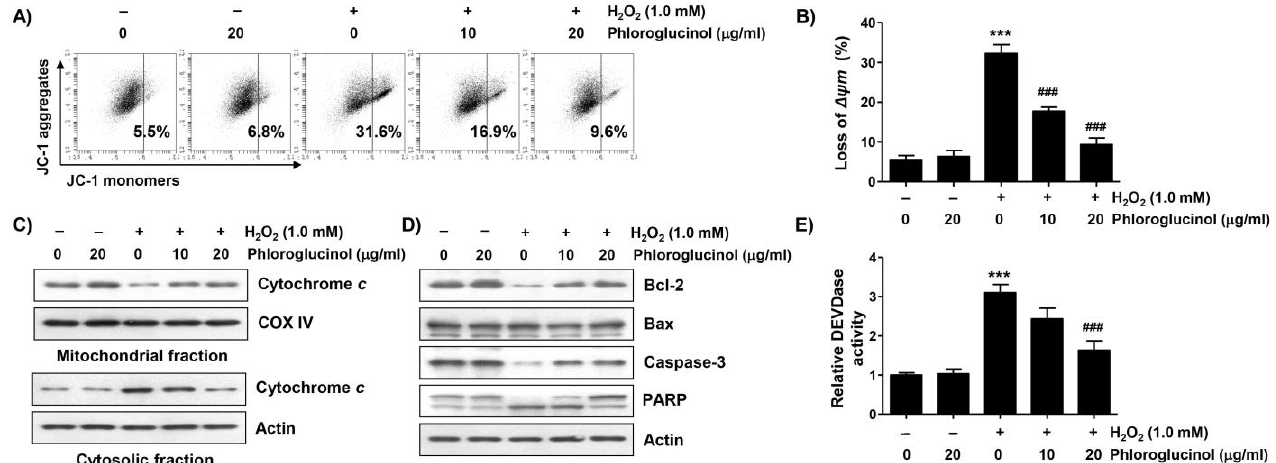
Figure 3. Phloroglucinol suppresses H 2 O 2 -induced mitochondrial impairment in C2C12 myoblasts. Cells treated with or without phloroglucinol for 1 h were treated with H 2 O 2 for 24 h. Cells were exposed to vehicle for control group. ( A ) Representative flow cytometry results according to 5, 5′ ,6, 6′ -tetrachloro-1, 1′ 3, 3′ -tetraethyl-imidacarbocyanune iodide (JC-1) staining are presented. ( B ) The JC-1 monomer ratio of cells in each treatment group was presented. ( C , D ) The expression levels of cytochrome c ( C ), Bcl-2, Bax, caspase-3, and poly(ADP-ribose) polymerase (PARP) ( D ) were investigated through immunoblotting. ( E ) Caspase-3 activity was measured using a colorimetric substrate. Statistical difference was determined by Student’s t -test (*** p < 0.001 vs. control group; ### p < 0.001 vs. H 2 O 2 -treated cells).